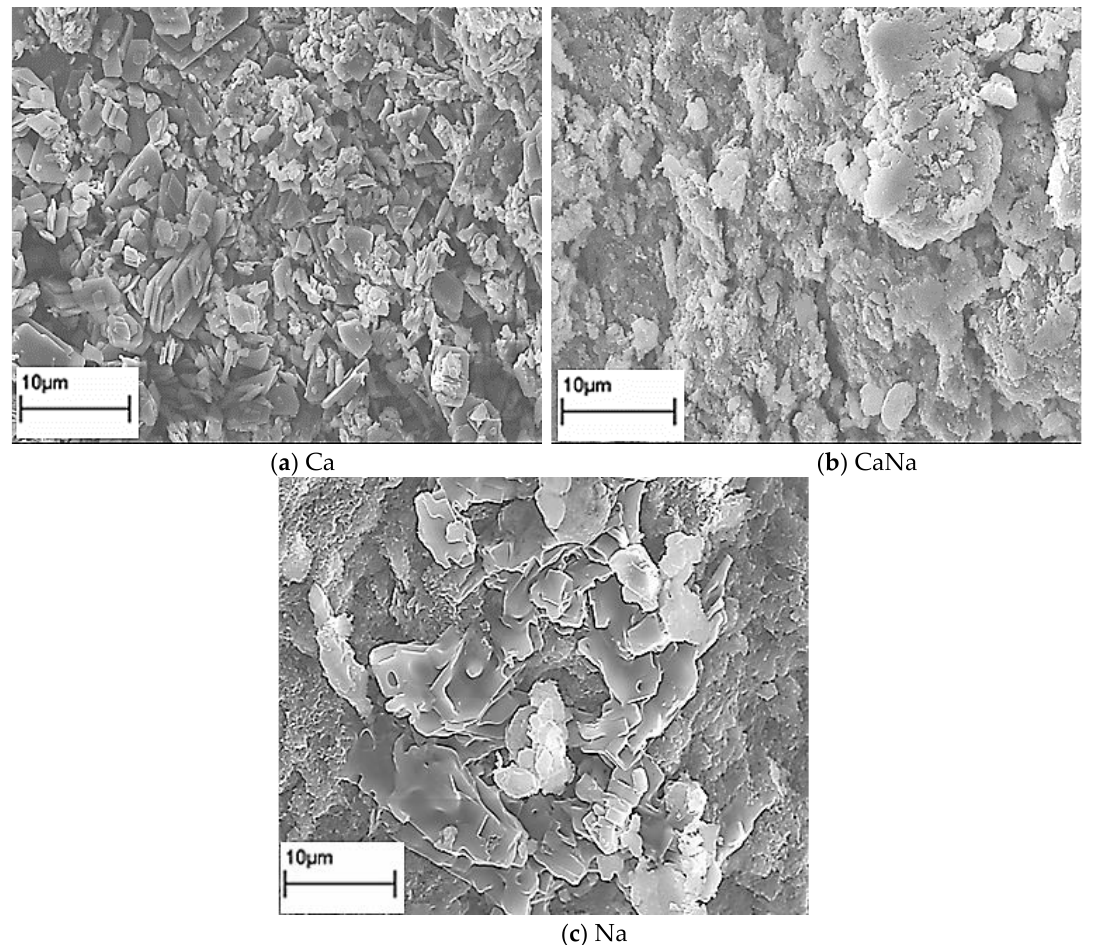
Figure 2. The SEM images of cement-salt stone: Ca ( a ), CaNa ( b ); Na ( c ). According to simultaneous thermal analysis (Figure 3a,b), the total weight loss of the powder mixture based on calcium citrate and MCPM when heated to 1000 ◦ C was 46%. brushite, namely, the conversion of brushite to monetite (~200 ◦ C, Equation (14)), and then monetite to pyrophosphate (~400 ◦ C, Equation (15)). There are two endothermic peaks